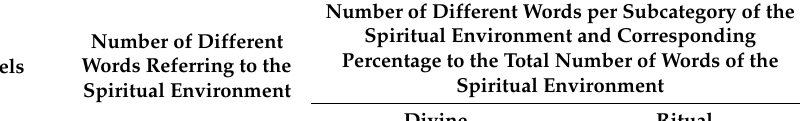
Table 12. Number of unique words referring to the spiritual environment. Number of Different Words per Subcategory of the Spiritual Environment and Corresponding Number of Different Percentage to the Total Number of Words of the Words Referring to the Gospels Spiritual Environment Spiritual Environment Divine Ritual